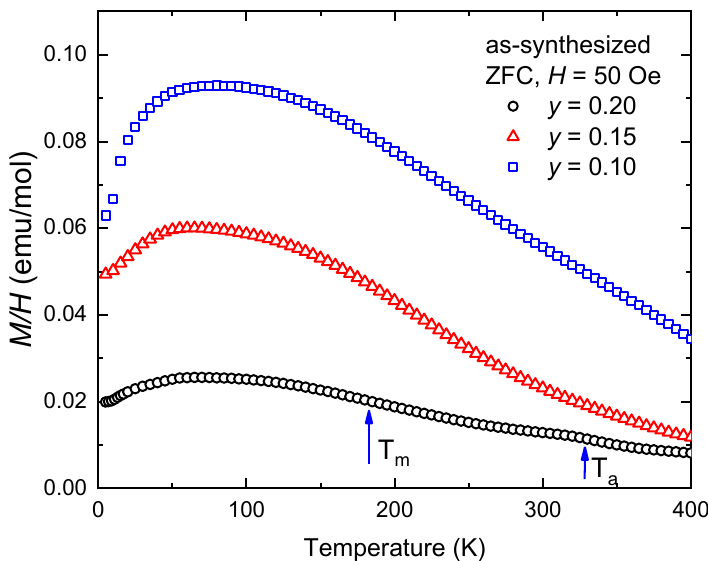
Figure 4. Temperature dependence of M/H of the as-synthesized BiFe 1 − y [Zn 0.5 Ti 0.5 ] y O 3 samples with 0.1 ≤ y < 0.2 measured in the ZFC regime in the temperature range of 5–400 K. The T m and T a were estimated from the derivative of the M/H(T) curve.